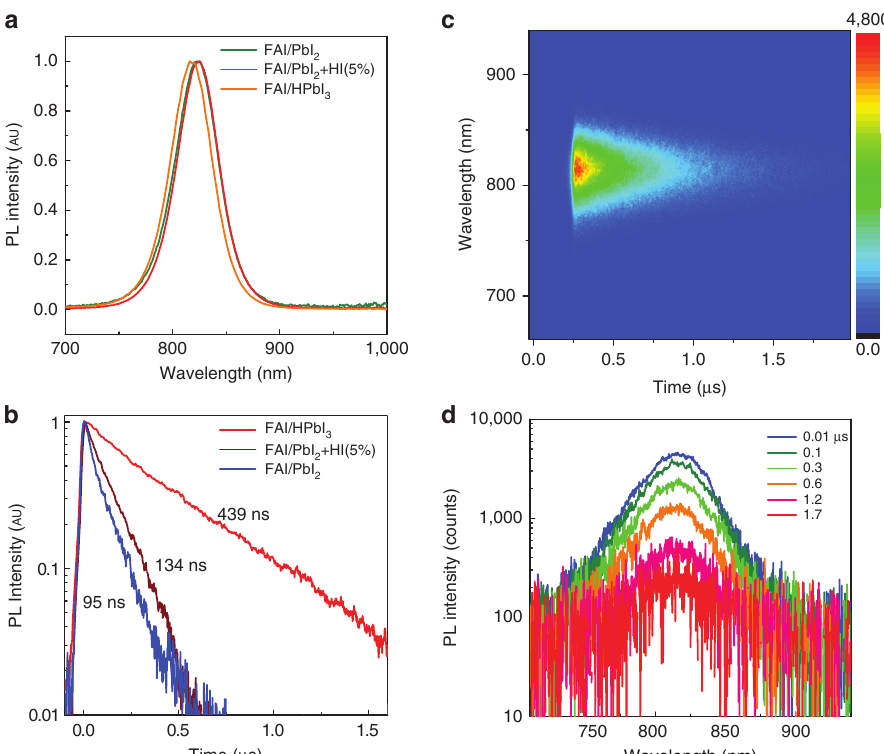
Figure 2 ( a ) PL spectra of FAPbI 3 fi lms prepared from different precursor systems. ( b ) Time-resolved PL decay at room temperature. ( c ) 2D pseudo-color plot of streak camera data from a FAI/HPbI 3 -based fi lm. ( d ) Log-plot of PL spectra at different times after photoexcitation. 2D, two-dimensional.